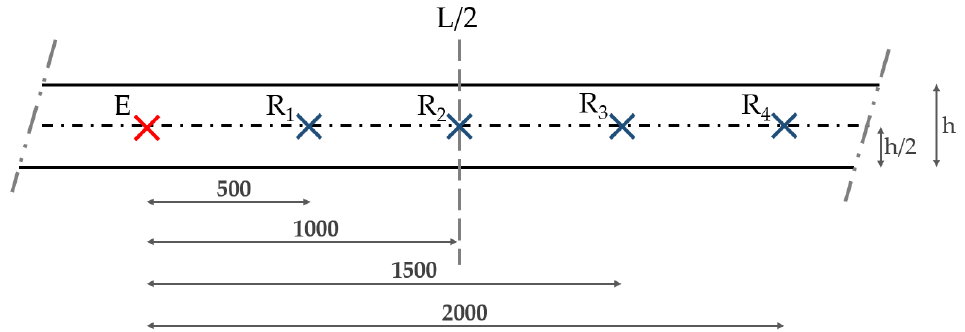
Figure 8. Layout of the sensors for the experimental determination of the MoE dyn of each wooden beam. Distances in mm.